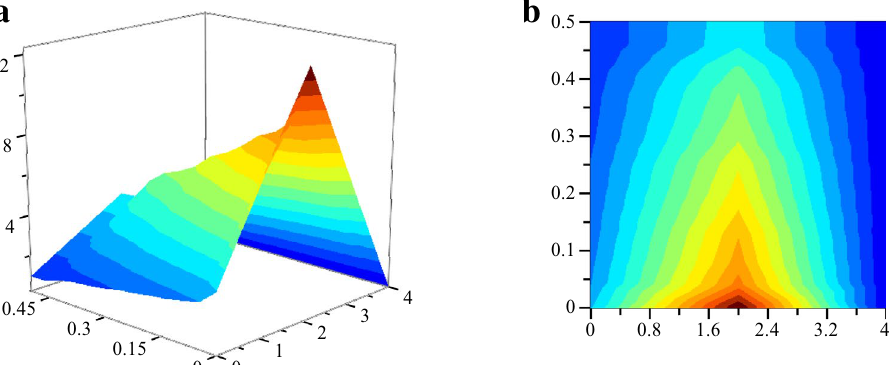
Figure 1. The three-dimensional relationship between the eigenroots, variance contribution rate, and correlation coefficient ratio is shown in the figure. ( a ) Three-dimensional relationship diagram of the parameters of the fuzzy factor model. ( b ) The z-axis projection of the three-dimensional relationship